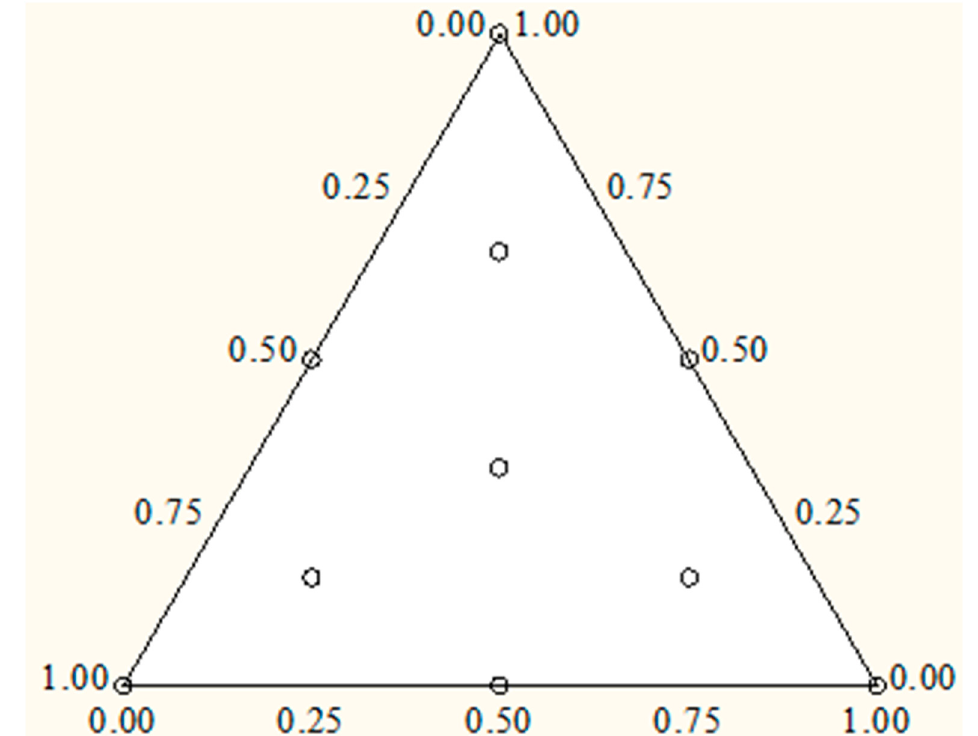
Figure 1. The experimental formulations, shown as a circle dot, for the binary and ternary blends of the PP/WF/GTR samples designed by a simple-centroid mixture methodology approach. Table 1. The melting behaviour of the composites with and without EB as a